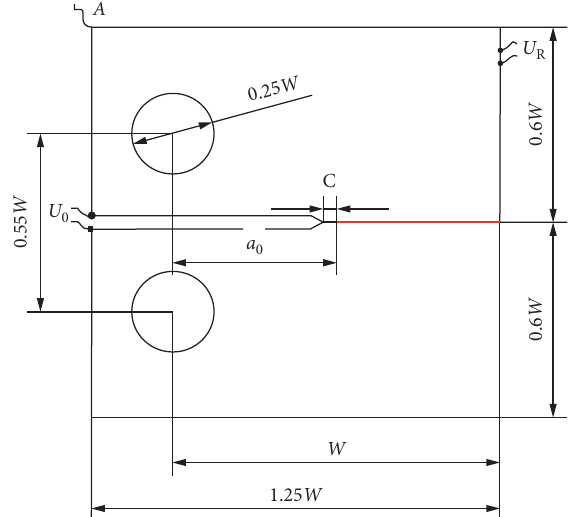
Figure 2: CT specimens’ geometry and shape.